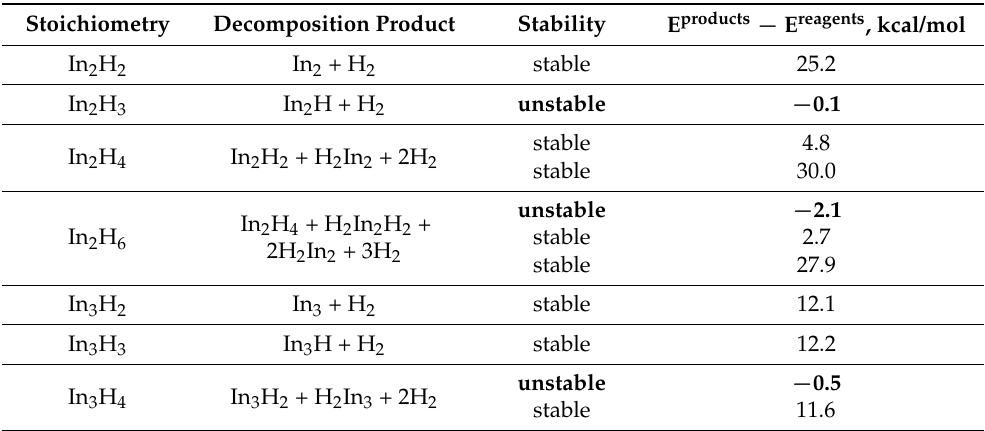
Table 1. Analysis of thermodynamic stability toward H 2 dissociation at the QRO-CCSD(T)/cc-pVTZ(- PP)//U-TPSSh/def2-TZVPP level of